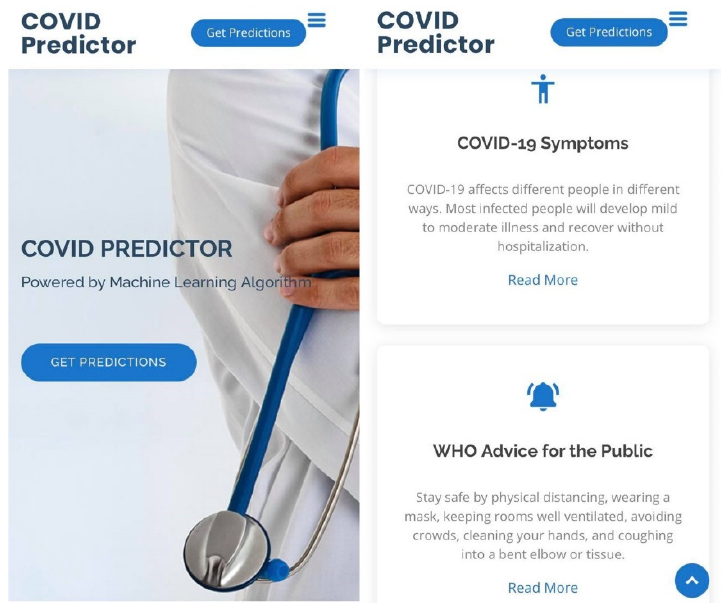
Figure 15. This is the dashboard, home, and about viewed in a mobile browser.